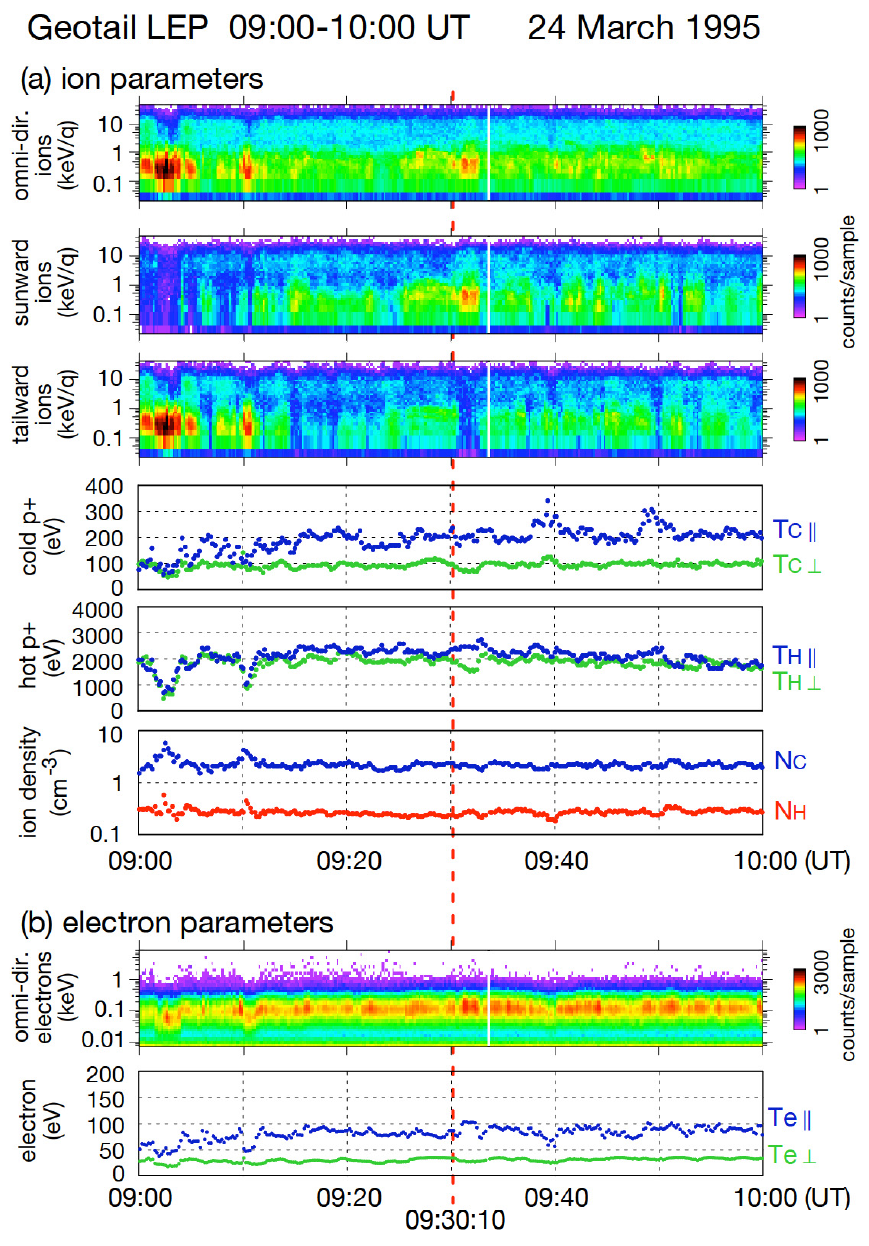
Fig. 1. Geotail observations between 09:00–10:00 UT on 24 March 1995. Panel (a) shows the ion observations. From the top, E-t spectrograms of omni-directional, sunward, and tailward ions, temperatures and densities of cold and hot proton components are presented. The perpendicular (parallel) temperature is shown by the green (blue) points, the density of the cold (hot) component is shown by the blue (red) points. Panel (b) shows the electron observations. E-t spectrogram of omni-directional electrons (7.4eV–8.5keV) and their temperatures are shown.